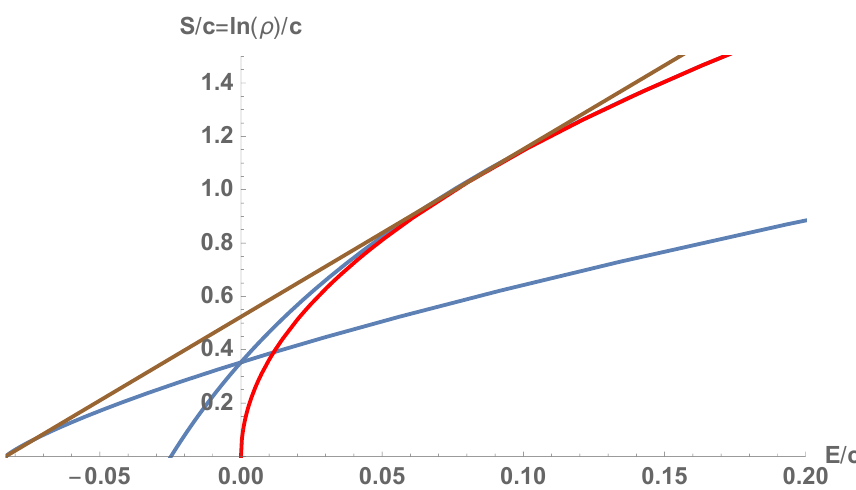
Figure 3 . Full density of states of the averaged Narain theory — U(1) gravity. Blue lines: S 1 /c and S 2 /c as functions of e = E/c , where the full density of states (entropy) of U(1) gravity is S = max( S 1 , S 2 ) . S 1 dominates for E < 0 and S 2 for E > 0 . Brown line: the sparseness condition 2 π ( e + 1 / 12) . S 1 ( e ) /c violates sparseness condition at small e + 1 / 12 . Red line: Cardy formula p ln( % ) /c = π 4 e/ 3